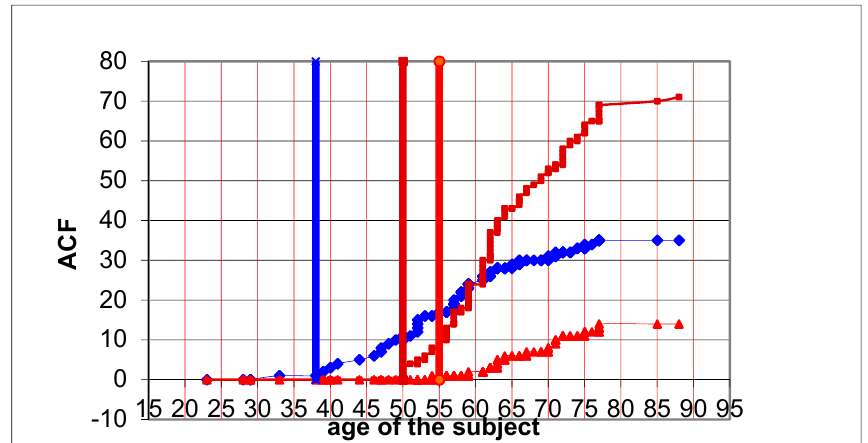
Figure 1. Prevalence of aberrant crypt foci (ACF) in age groups. Blue line: ACF < 5; brown line: ACF 5–10; red line: ACF > 10 0.